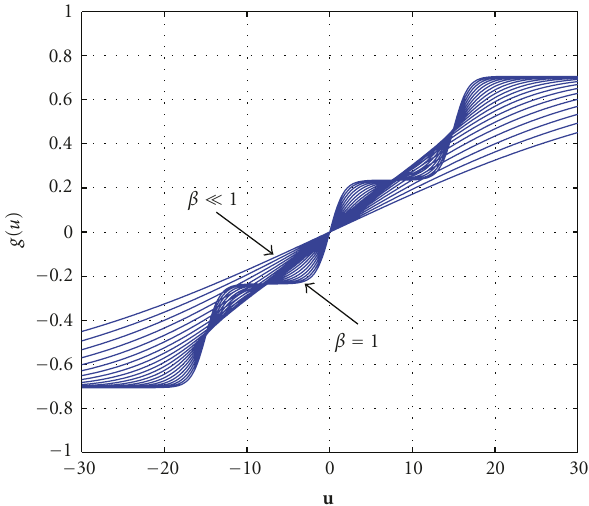
Figure 7: Simulated annealing on the four-level decision function for Z = 20 iterations.